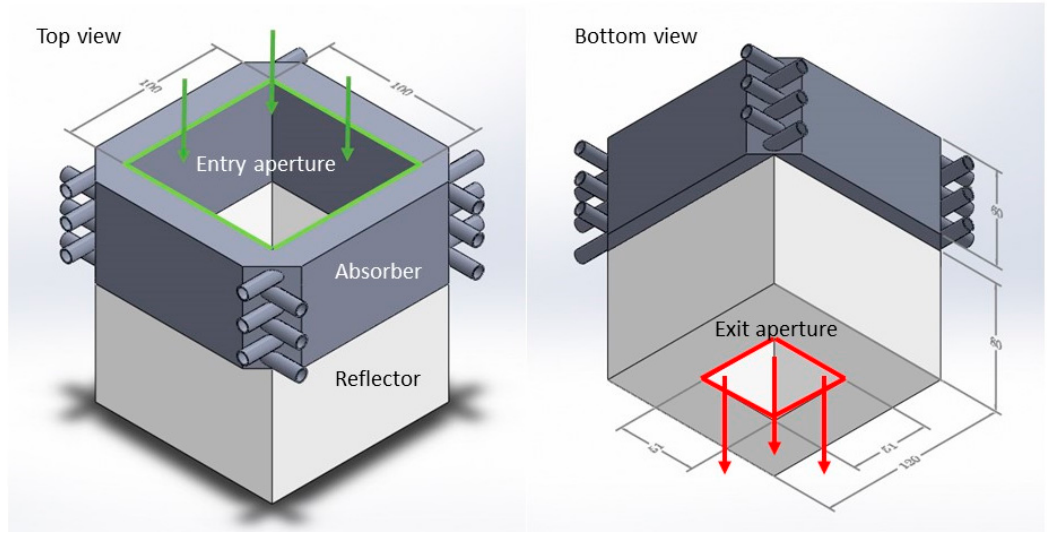
Figure 4. Basic A/R CCPC structure with absorber on top and reflector at bottom. Entry aperture of 0.1 × 0.1 m 2 and exit aperture at 0.05 × 0.05 m 2 .